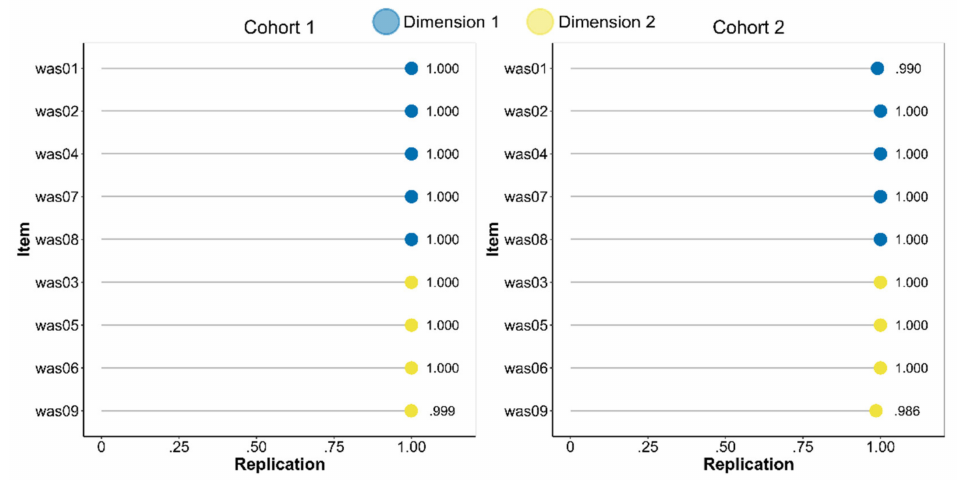
Figure 4. Items’ proportions of replication in the original dimension as specified by the Exploratory Graph Analysis.